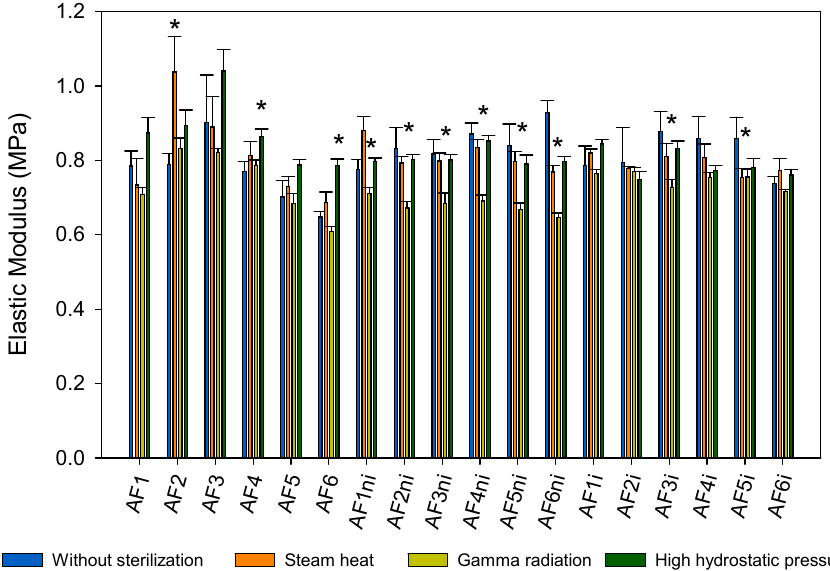
Figure 7. Elastic modulus (MPa) obtained for all hydrogels hydrated with 0.9% NaCl before and after each sterilization method. (*) Statistically different from the nonsterilized hydrogels (Kruskal–Wallis test and Games–Howell post hoc test, p < 0.05).